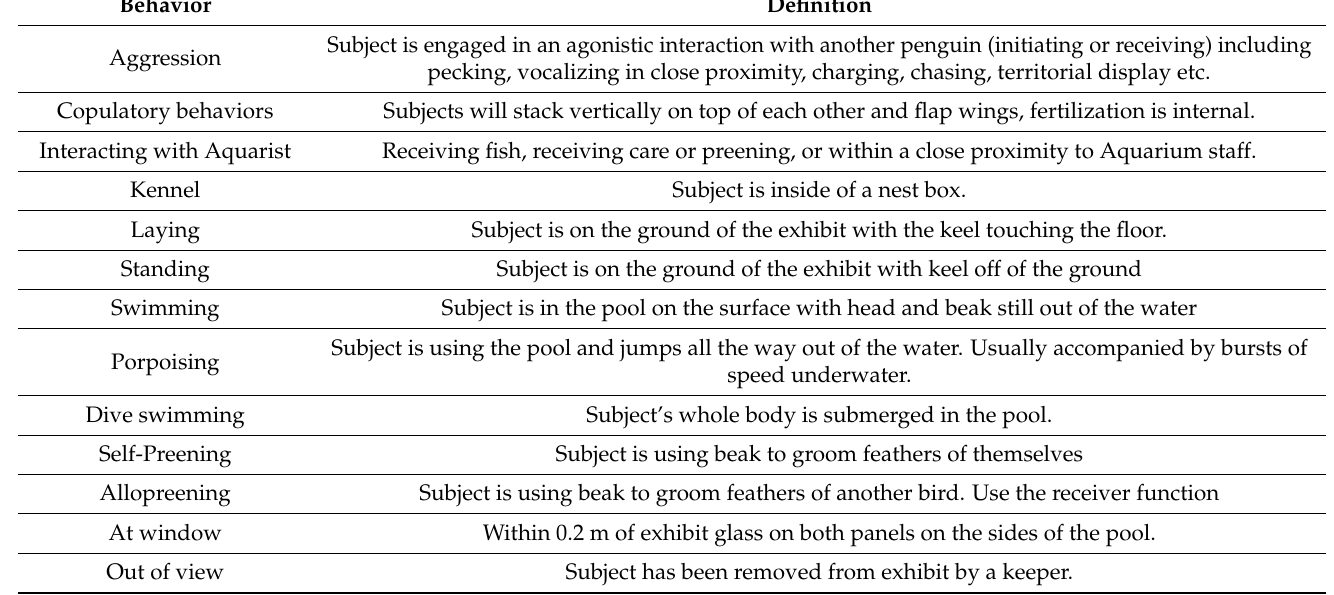
Table 2. Animal Behaviour Pro Ethogram. All behaviors were considered to be states, and the state of each individual penguin was recorded every minute during each 10-min observation period. Aggression, copulatory behavior, and allo-preening were analyzed as all-occurrence behaviors to support comparisons with Zoo Monitor data.